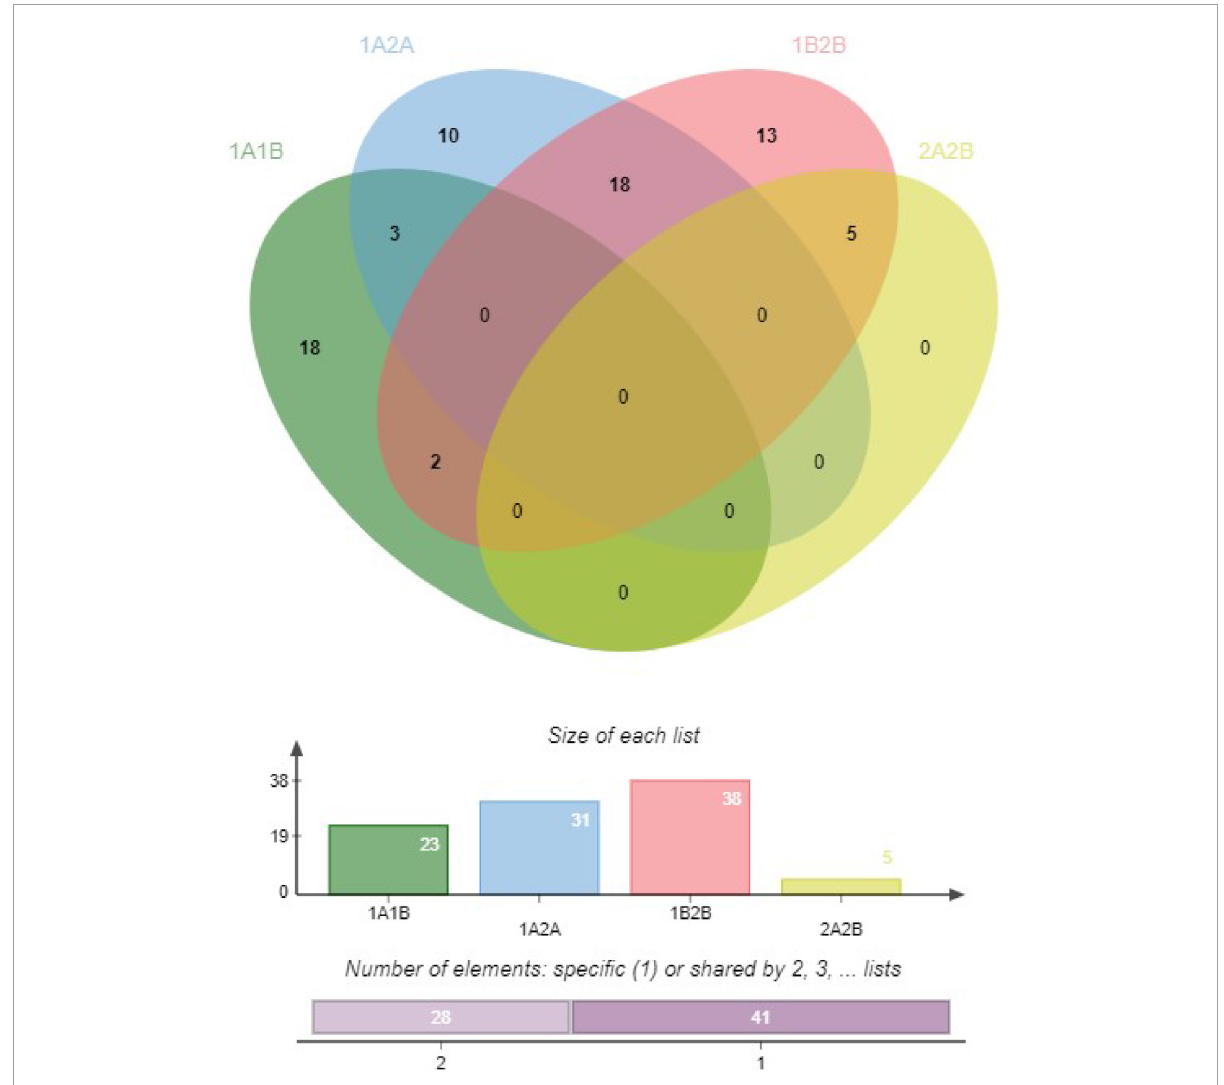
FIGURE5 A venn diagram showing the distribution of differential expressed lncRNA in the four conditions that are compared in this